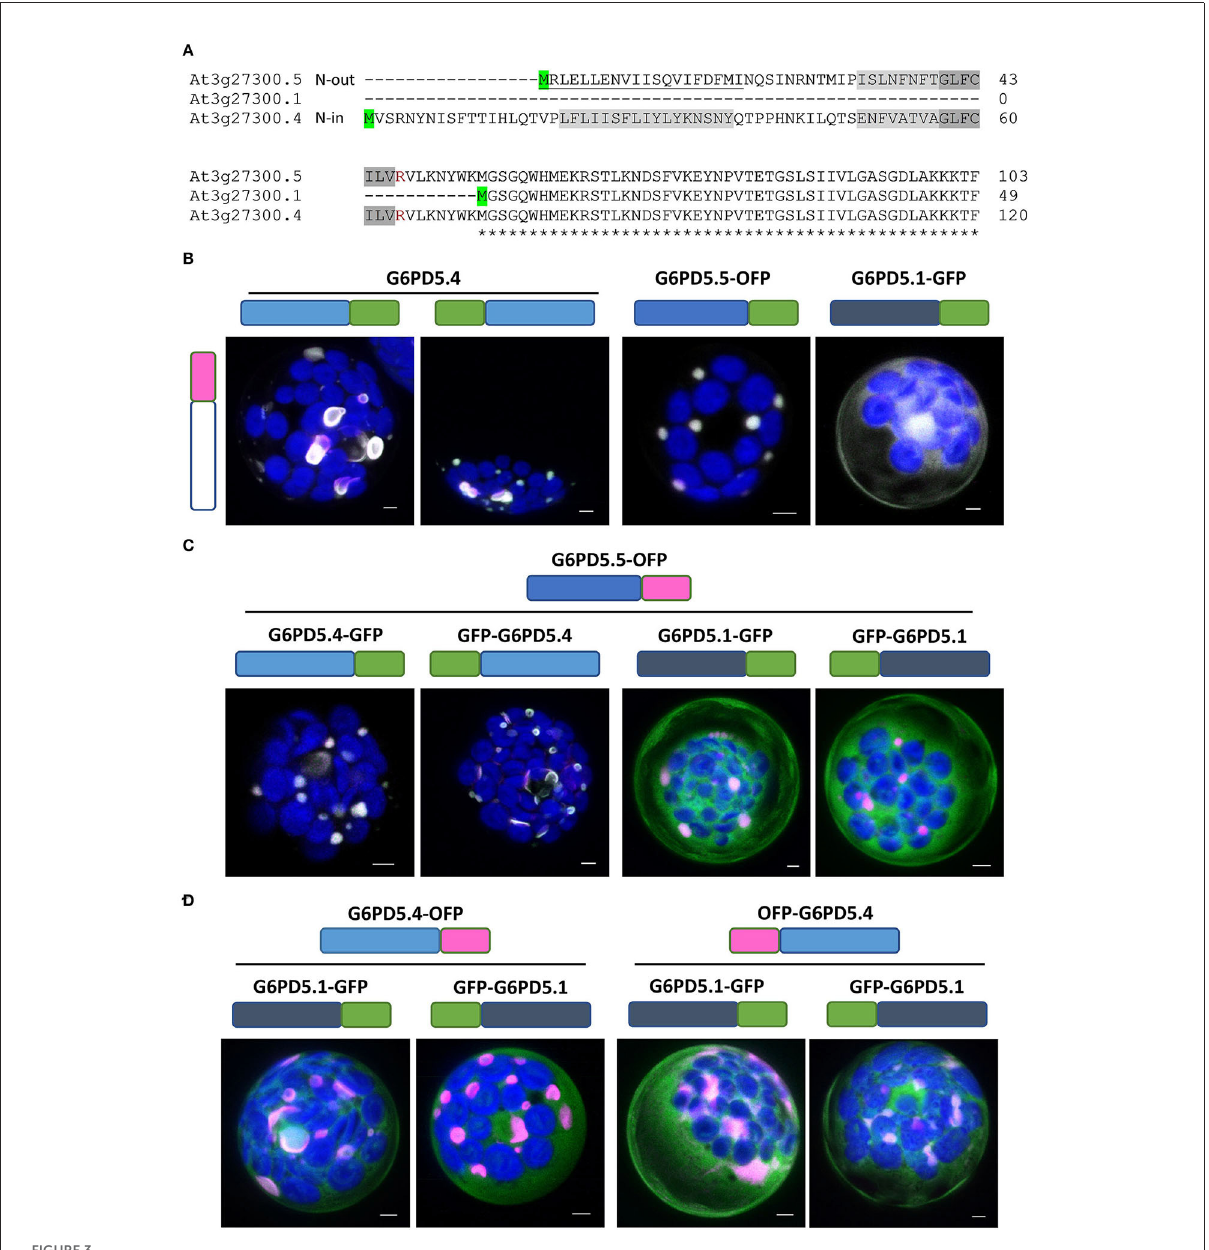
FIGURE3 Extent of co-localization among the same or different G6PD5 proteoforms. (A) N-terminal part of a sequence alignment (CLUSTAL Omega) of the three G6PD5 proteoforms. Start codons are highlighted in green. Relative to the transmembrane regions (shaded gray, identical parts dark gray), the N-terminus of G6PD5.5 is predicted by ARAMEMNON as N-out (signal peptide, underlined) and of G6PD5.4 as N-in (cytosolic). (B) Homotypic co-expression of the same proteoform (open symbol); (C,D) heterotypic co-expression of different proteoforms. If not indicated, the images show maximal projections of about 30 optical sections as a merger of all channels (for single channel images, refer to Supplementary Figure S2). GFP in green, OFP in magenta, and chlorophyll autofluorescence in blue; white signals indicate co-localization of GFP and OFP (or very close signals < 200nm). Scale bars, 3 µ